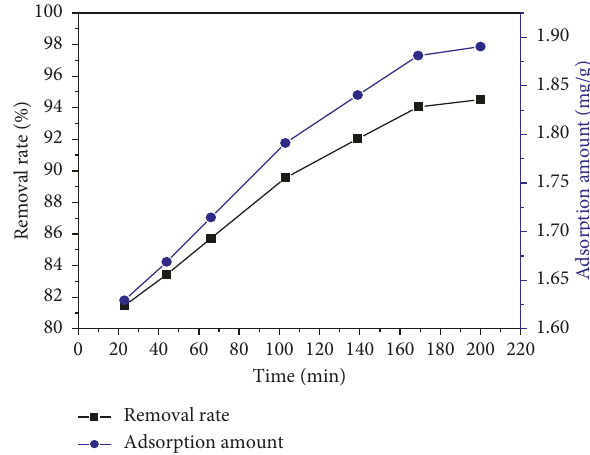
Figure 3: Effect of time on uranium adsorption by modified rice stem.